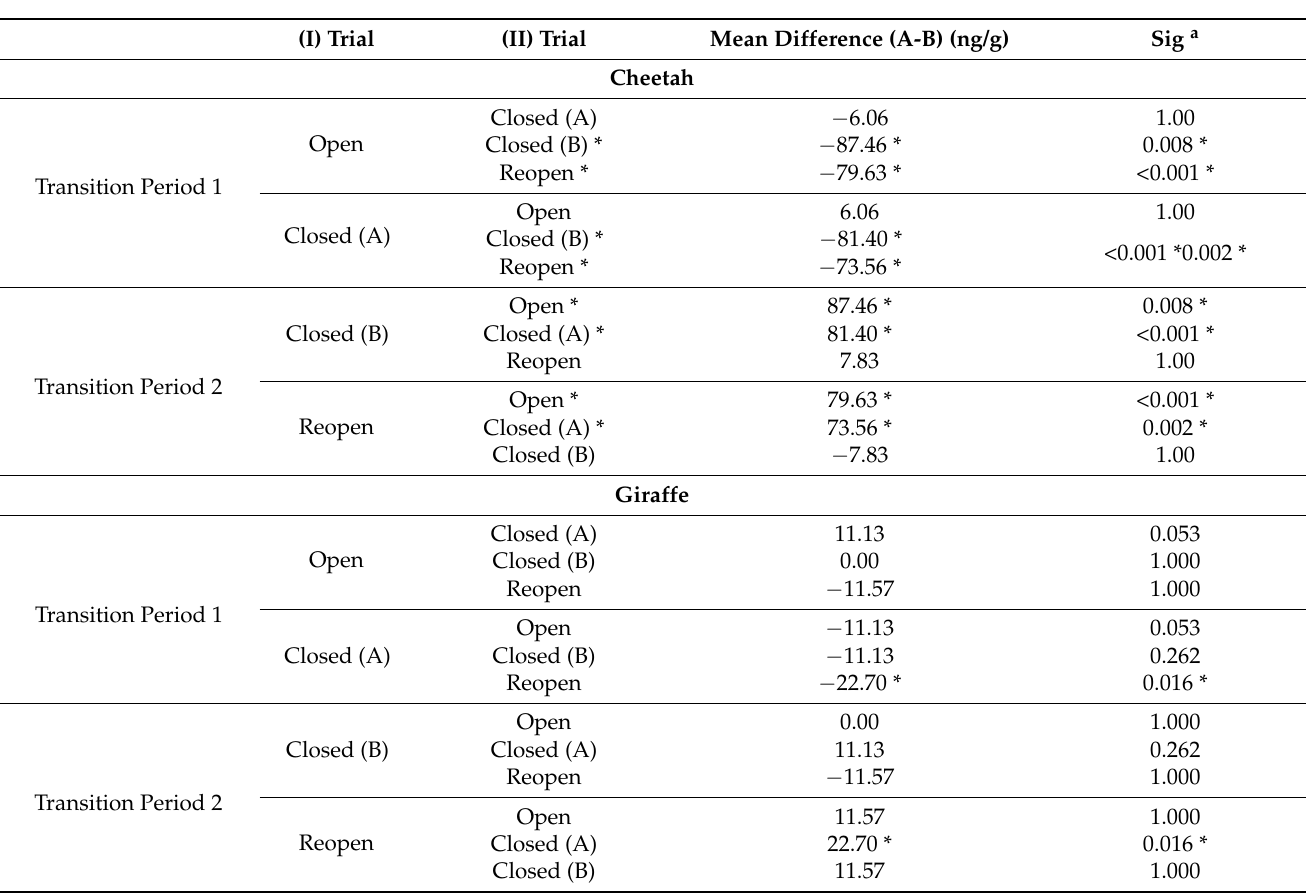
Table 5. Results of cheetah and giraffe fGM concentration analysis. Repeated measures two-way mixed ANOVA model comparing different zoo opening statuses. The mean difference results compare fGM concentrations in (I) trials with those in (II) trials. Asterisks (*) indicate significant ( p < 0.05) differences between trial (I) and trial (II). a Bonferroni correction for multiple